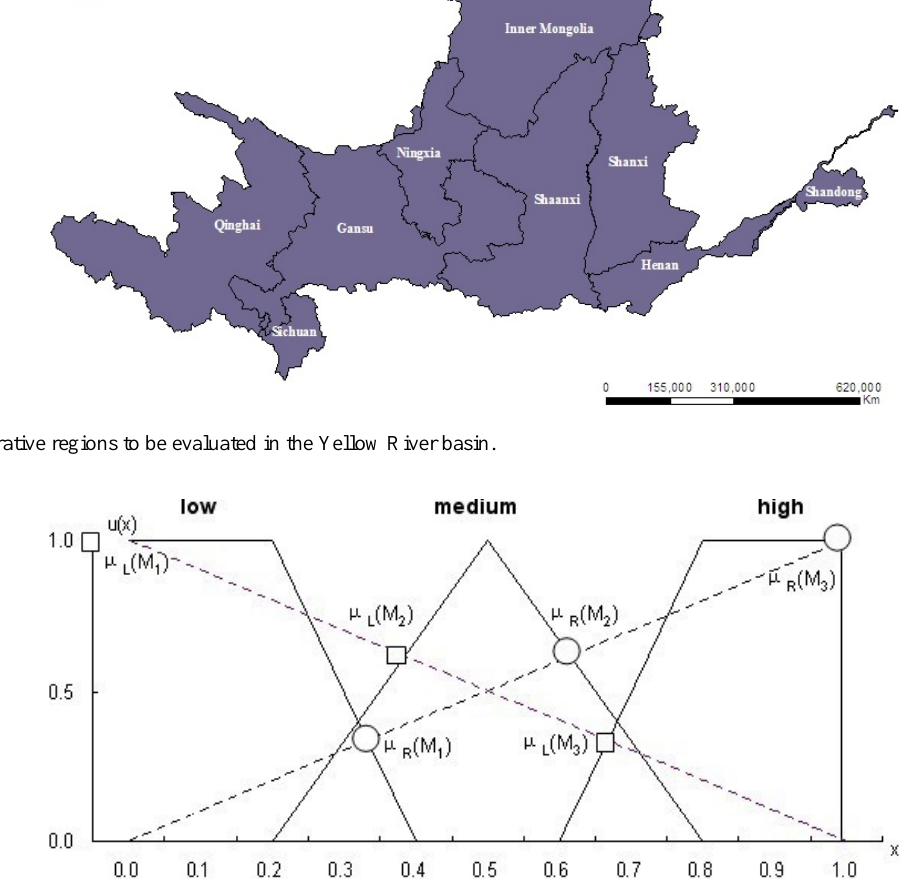
Fig. 3. One scale for the graph of membership function (Hwang and Chen,